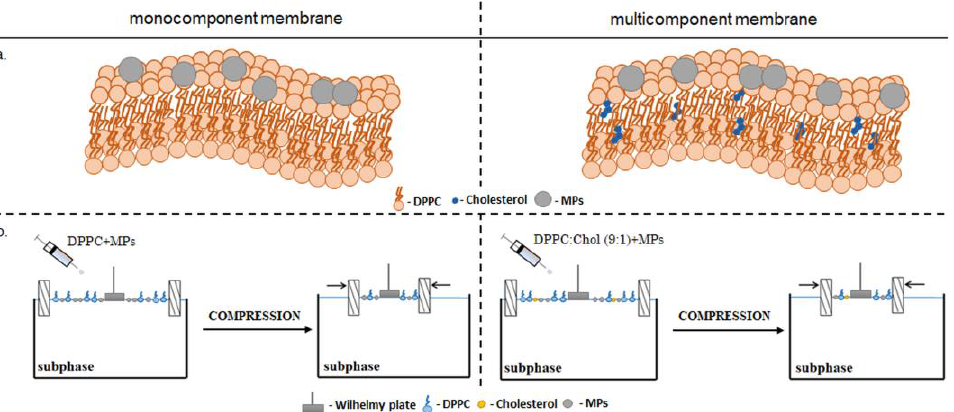
Figure 6. The idea of the Langmuir monolayer method: ( a ) schematic drawing of the model membranes, ( b ) schematic idea of isotherm π– A experiments.